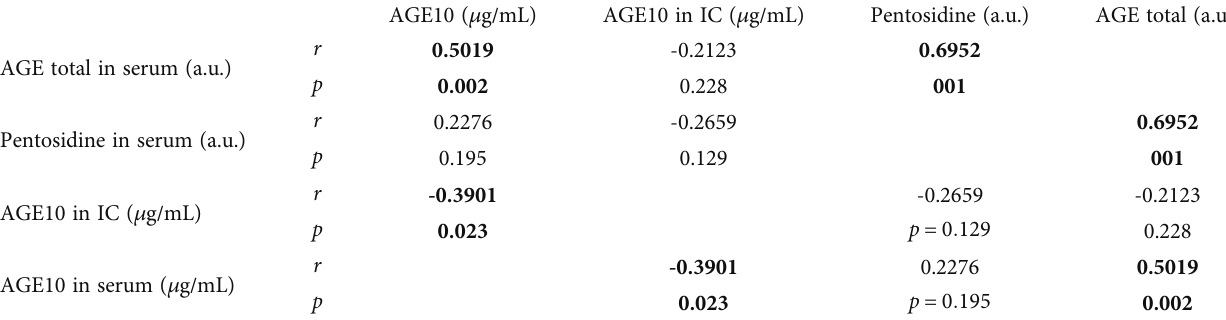
Table 1: Correlations between studied